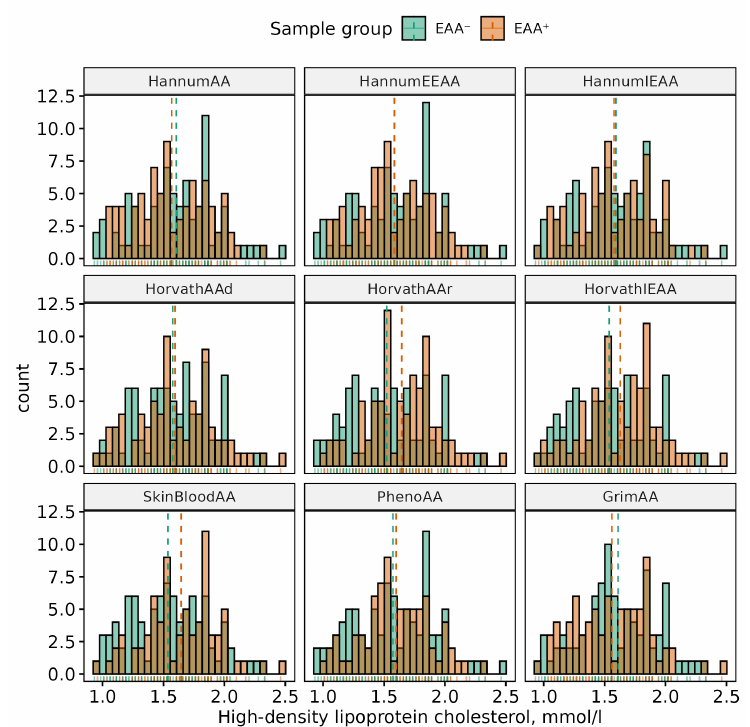
Figure A8. Histograms of distributions of HDL levels in females in EAA + and EAA − groups. Dashed lines correspond to the group